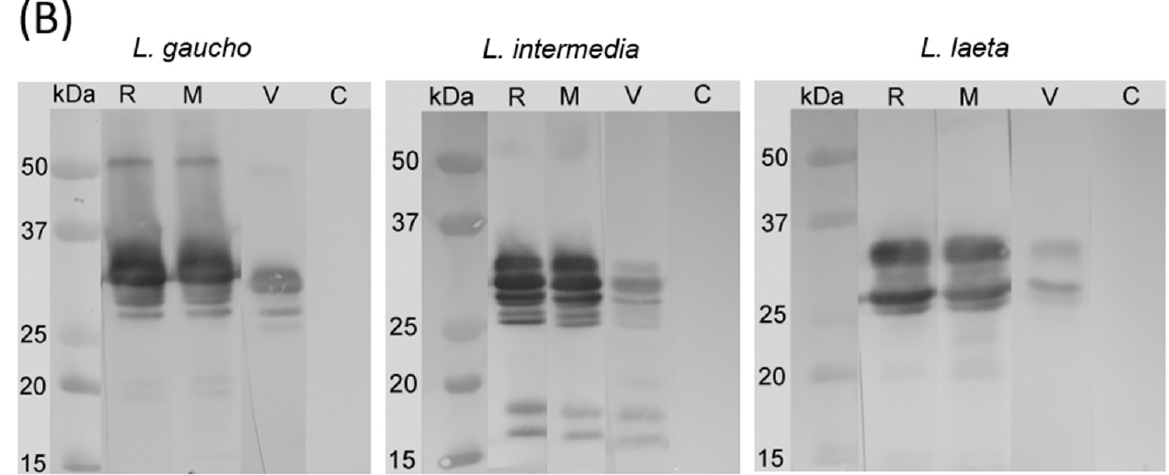
Figure 4. Reaction of produced sera with Loxosceles venoms. ( A ) ELISA for antibody capture assay with plates coated with L. intermedia venom (600 ng/well) and reacted with sera collected immediately before each immunization step (1:400 dilution). Antivenom: AV serum. Recombinant proteins: REC serum. Mix: MIX serum. C-: C serum. A pre-immune serum was used as control. Samples were analyzed in triplicates, and each point represents the mean ± SD. Results were statistically significant for all groups compared with C- (ANOVA, p < 0.0001). Results of Recombinant proteins’ group were statistically different from all other groups (ANOVA, p < 0.0001). No significant difference was found between Antivenom and Mix groups. ( B ) Western blotting showing immunological cross-reactivity among Loxosceles venoms and produced sera. Samples of venom (10 µg) from L. gaucho , L. intermedia, and L. laeta were probed with the produced sera (1:1000 dilution). R: REC serum. M: MIX serum. V: AV serum. C: C serum. A pre-immune serum was also used as control. Molecular protein mass standards are shown on the left of figures.